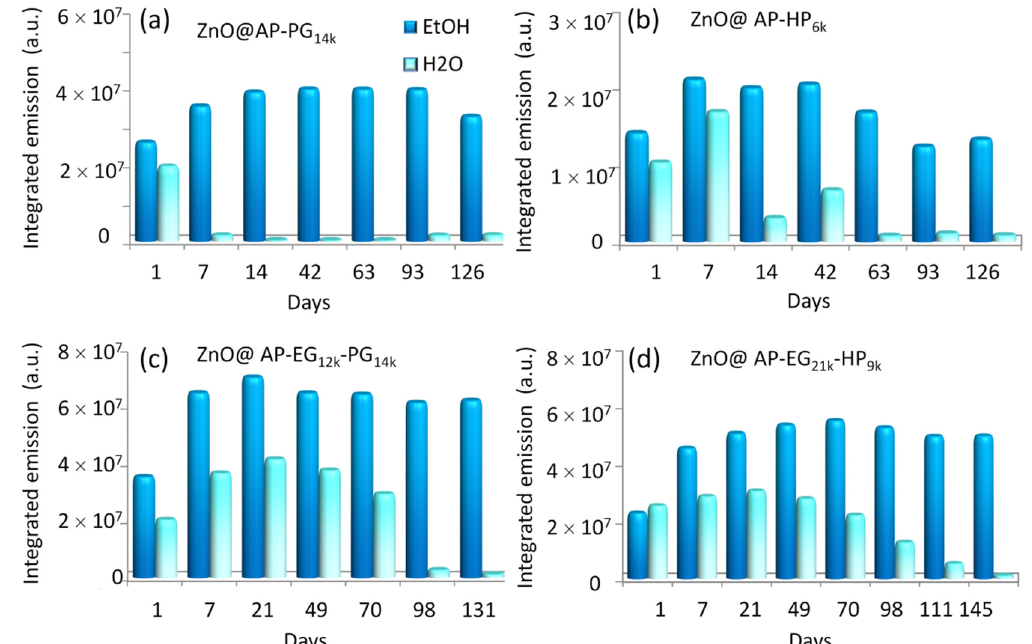
Figure 5. Integrated fluorescence emission as function of incubation time, for ZnO@AP-polymer in ethanol and water, synthesized with a combination of APTES (AP, 3.5% mol) and ( a ) PG 14k homopolymer, ( b ) HP 6k homopolymer, ( c ) EG 12k -PG 14k block copolymer, and ( d ) EG 21k -HP 9k block copolymer.